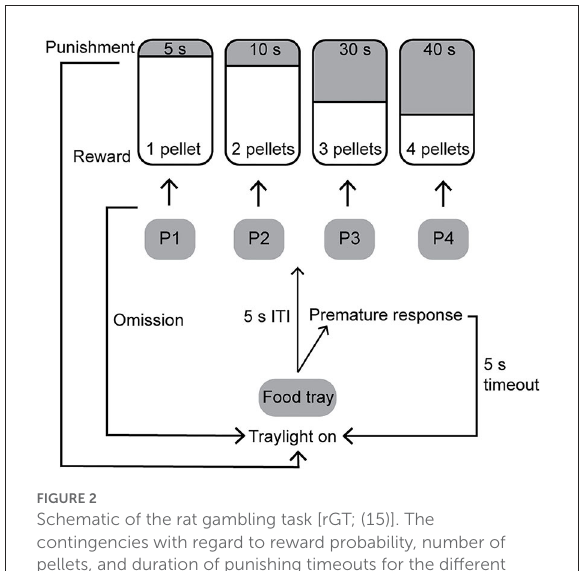
FIGURE2 Schematic of the rat gambling task [rGT; (15)]. The contingencies with regard to reward probability, number of pellets, and duration of punishing timeouts for the different options were: P1 p = 0.9, 1, and 5s; P2 p = 0.8, 2, and 10s; P3 p = 0.5, 3, and 30s; P4 p = 0.4, 4, and 40s. ITI, inter-trial